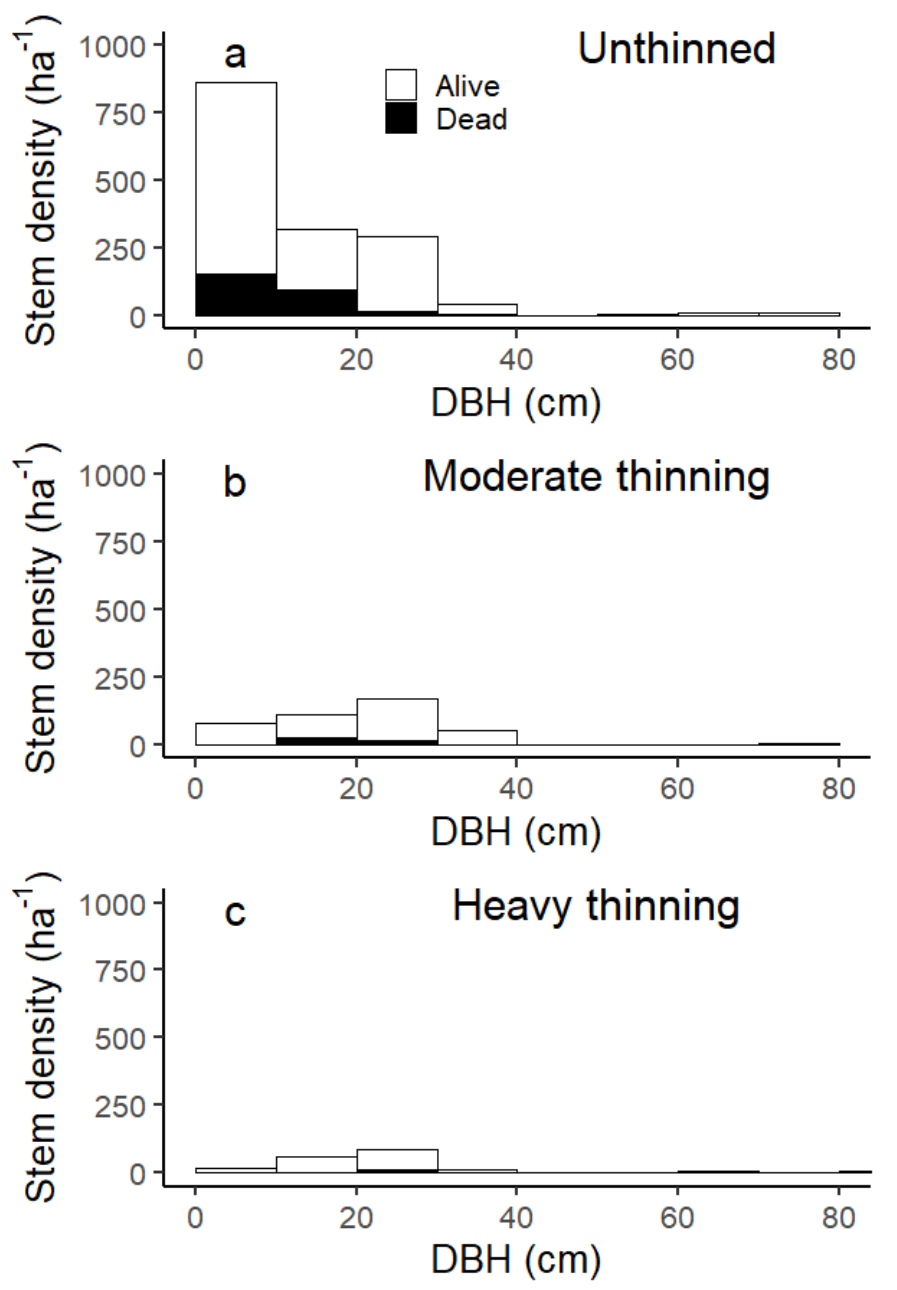
Figure A4. ( a ) Stem density in 2009 and the share of dead trees by 2019. No mortality occurred between 2014 and 2019 for the thinned stands. ( b ) The share of dead trees compared to stem density in 2009 is 18.2% for unthinned conditions, ( c ) 12.8% for moderate thinning, and 9.8% for heavy thinning.